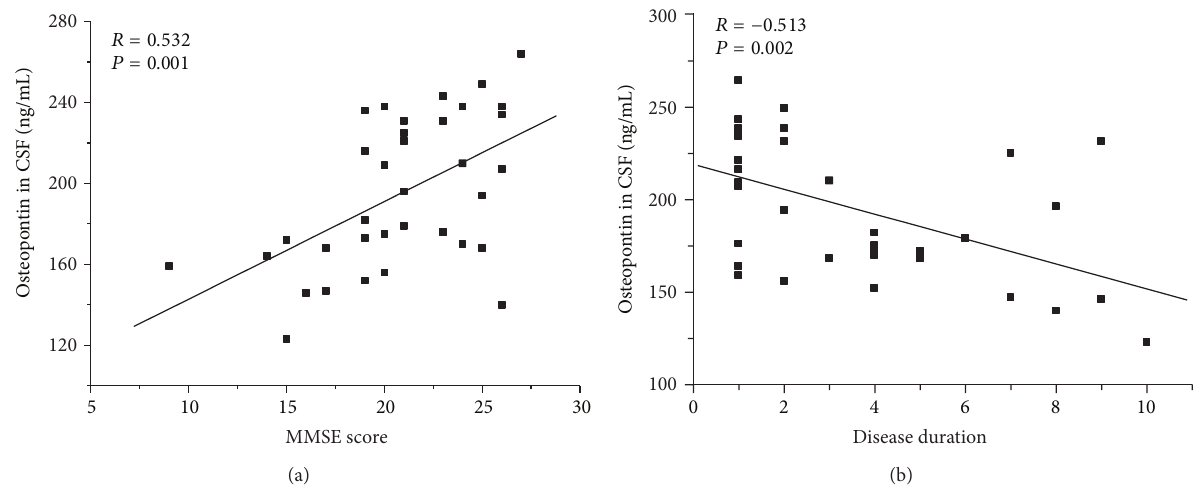
Figure 4: Correlation coefficients were computed to evaluate the relationship between cerebrospinal fluid (CSF) osteopontin levels and the degree of cognitive decline or disease duration in AD patients. (a) A positive correlation between CSF osteopontin levels and the Mini-Mental State Examination Score (MMSE) score in AD patients. (b) The CSF OPN concentration was correlated inversely with the disease duration.